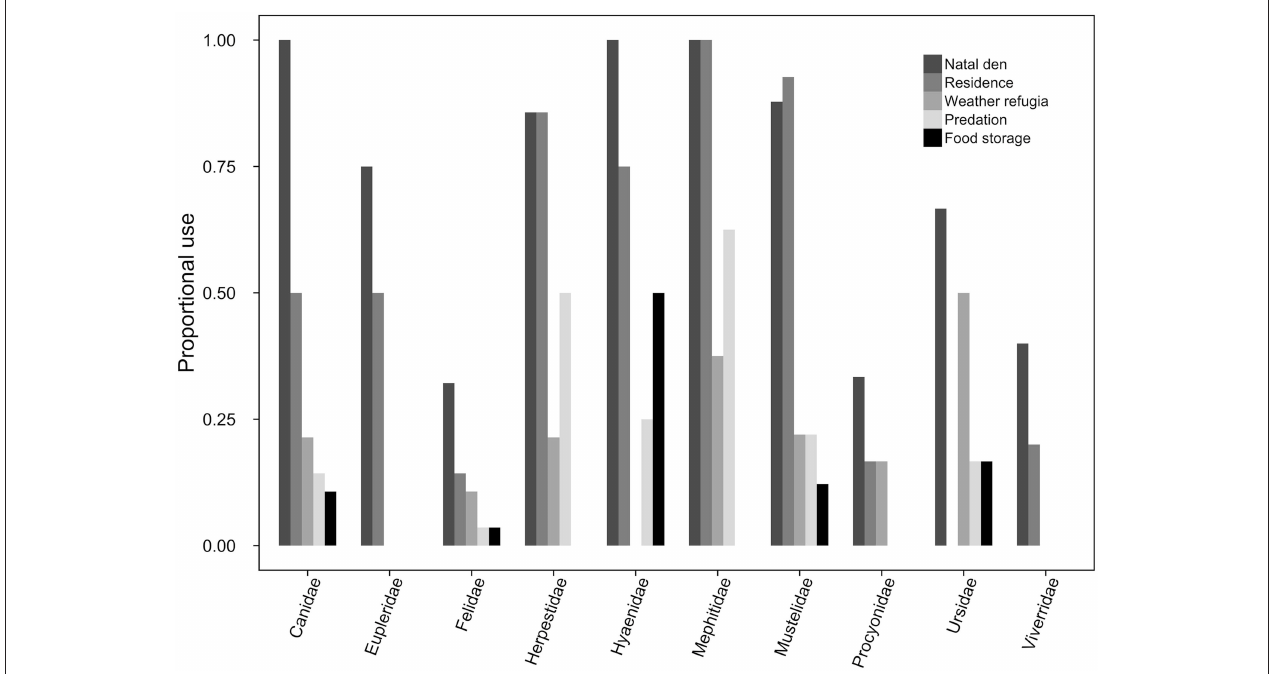
FIGURE 1 | For each carnivore family, the proportion of species exhibiting at least facultative use of subterranean dens for each of the behavioral use categories (i.e., natal dens, residences, weather refugia, predation refugia, and food storage).